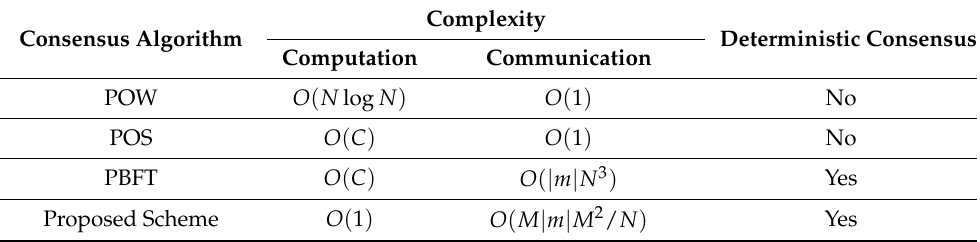
Table 4. Consensus methods performance